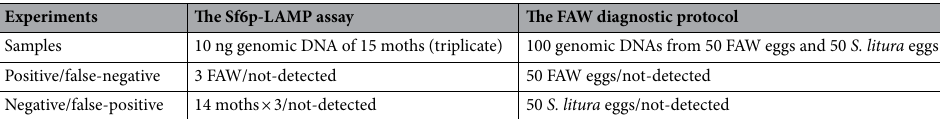
Table 1. Summary of validation experiments for the Sf6p-LAMP assay and the FAW diagnostic